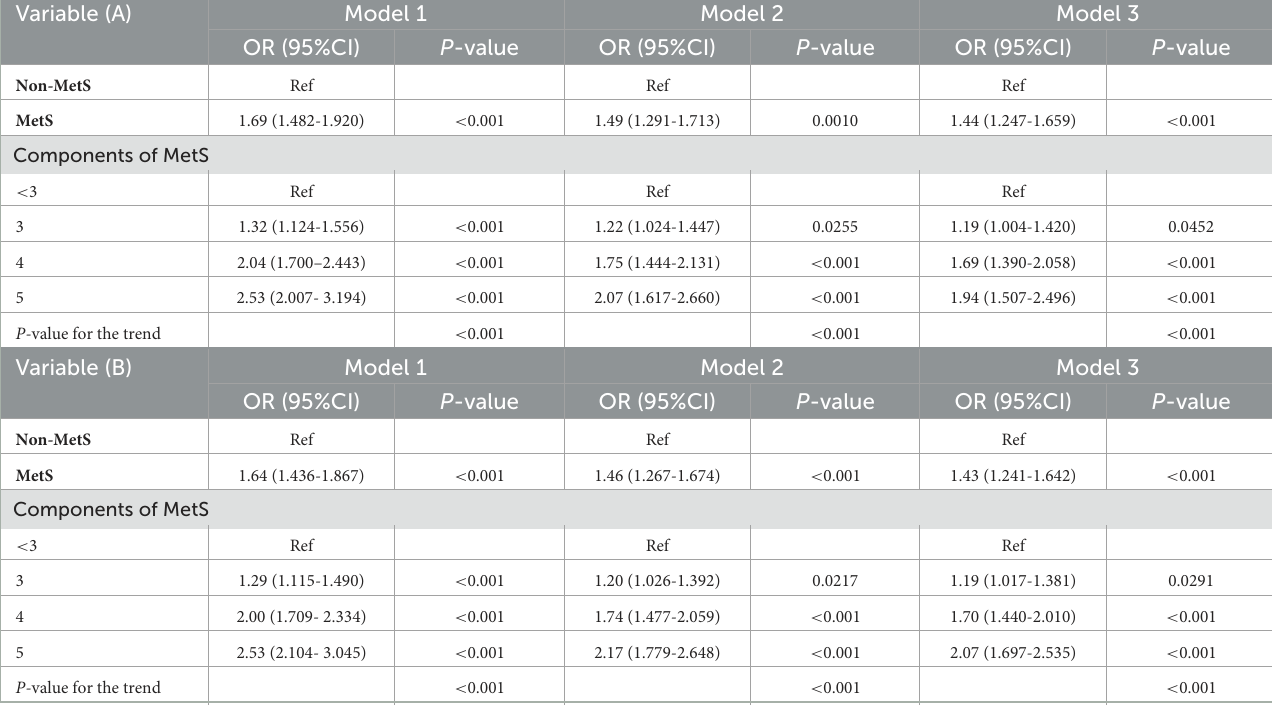
TABLE 3 Association of MetS and its components with depression in the original and the weighted cohorts.